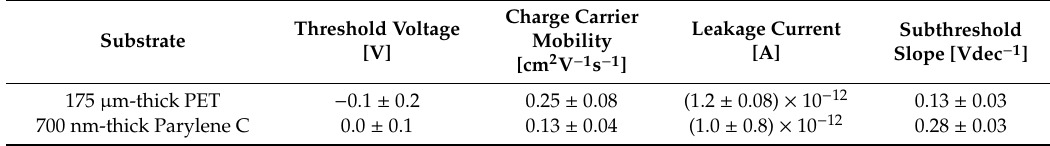
Table 1. Average and 1- σ confidence band for the basic electrical parameters of OFETs fabricated on PET (evaluated on 50 devices) and Parylene C substrates (evaluated on 30 devices).